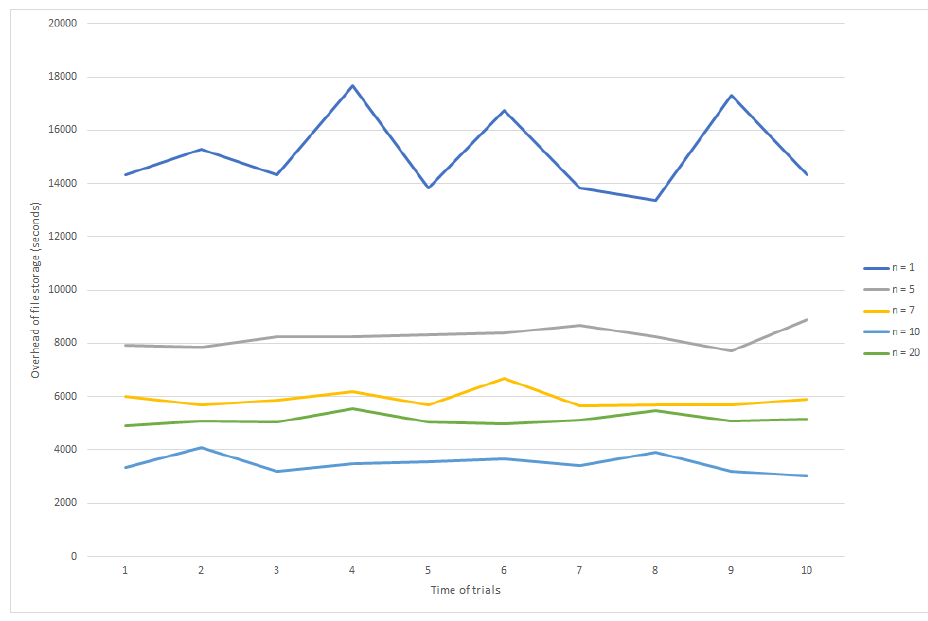
Figure 12. Overhead of two schemes to deal with big data